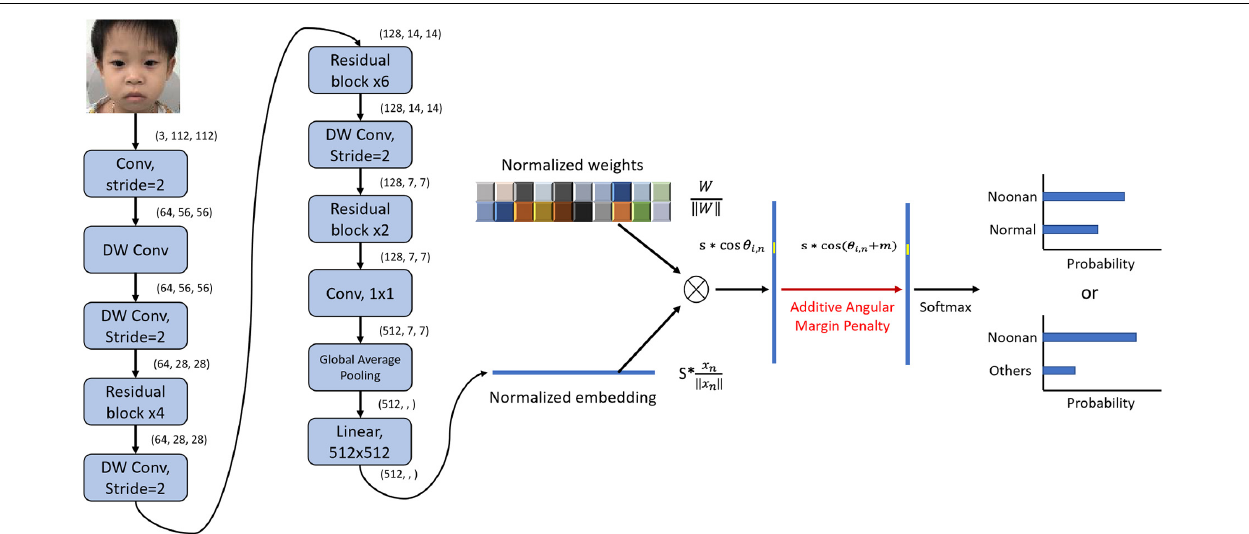
FIGURE 2 | Architecture of DCNN-Arcface model for Noonan syndrome identification. We used convolutional layers with stride = 2 instead of max-pooling to half the feature map size and double channels number. After extracting the embeddings with multiple convolutional layers, we normalized the weights of the last fully connected layer (cid:107) W i (cid:107)= 1 with L 2 normalization and rescaled the norm of embedding vector to s, (cid:107) χ n (cid:107)= s . Then, an angular margin penalty m was added to the target angle